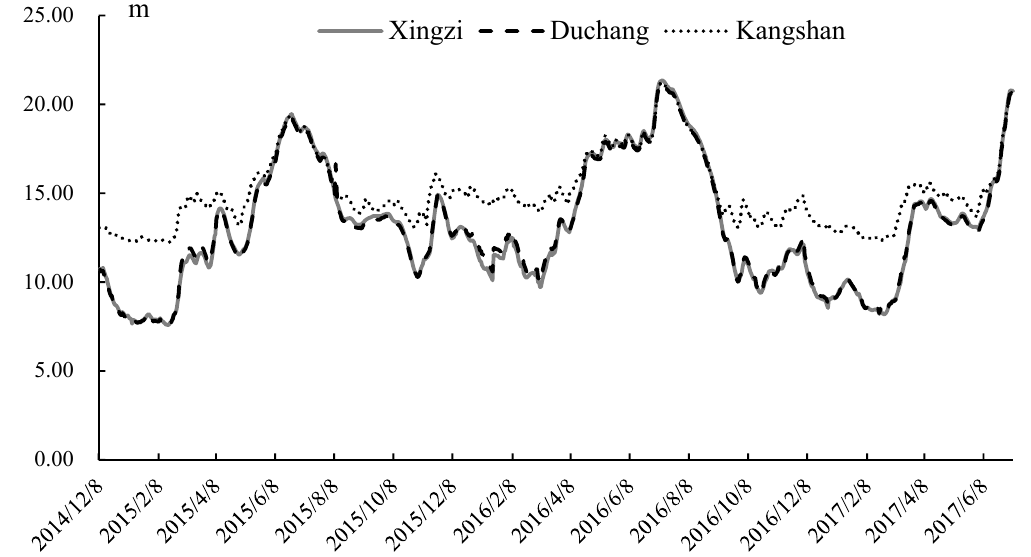
Figure 2. Water level of Xingzi, Duchang, Kangshan stations from 2014/12/08 to 2017/07/08. Table 1. Correlation between water level at Xingzi, Duchang, Kangshan stations.